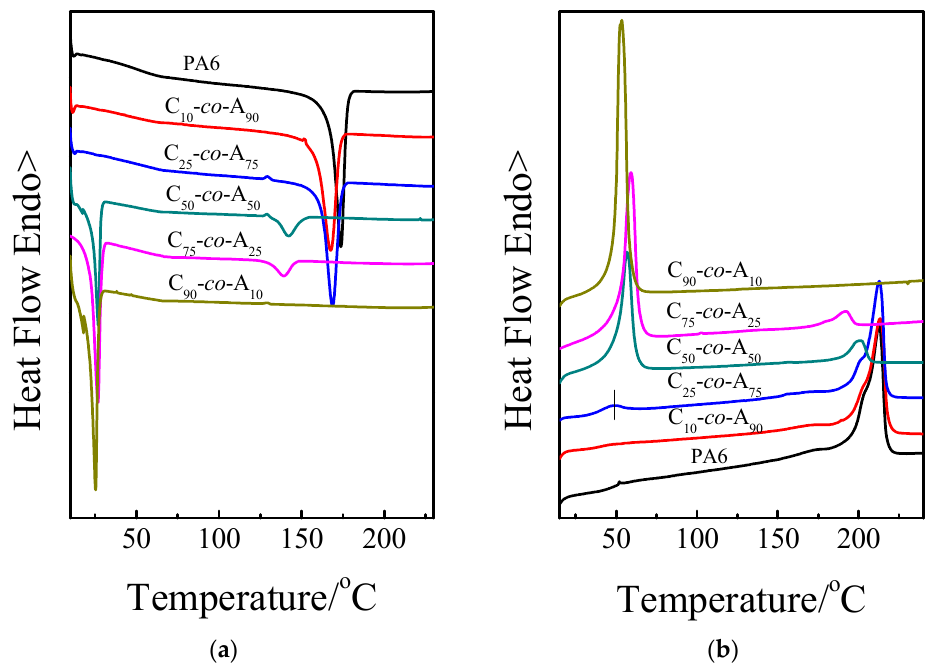
Figure 4. ( a ) The DSC cooling and ( b ) the second heating scans of P(CLA- co -CLO) copolymers. (The cooling and heating rate were 40 and 20 °C/min respectively.).